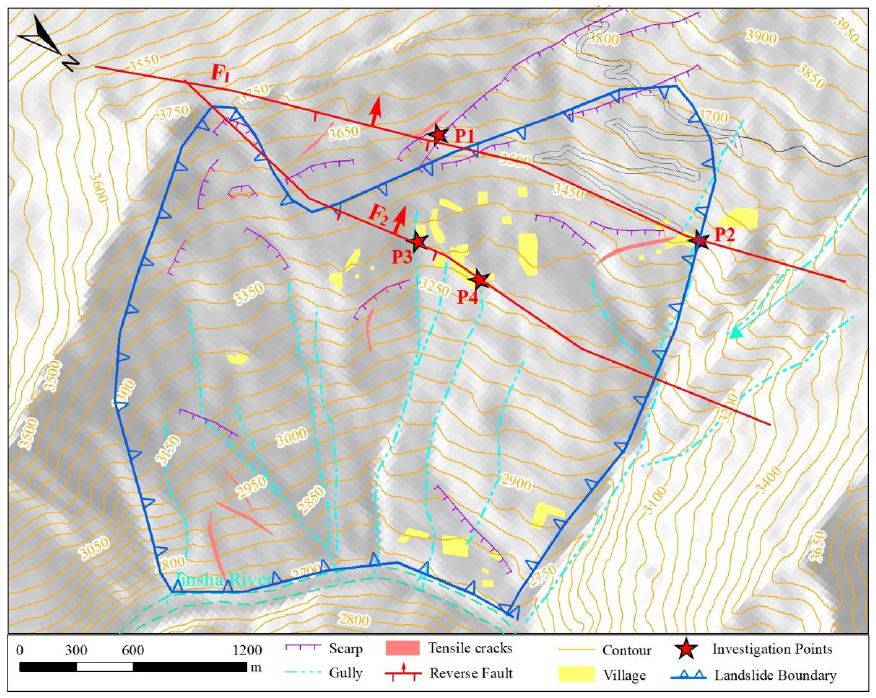
Figure 16. The reverse faults (F1 and F2 marked in red lines) cross the Xiongsong landslide (fault and landslide data from references [10,33]).